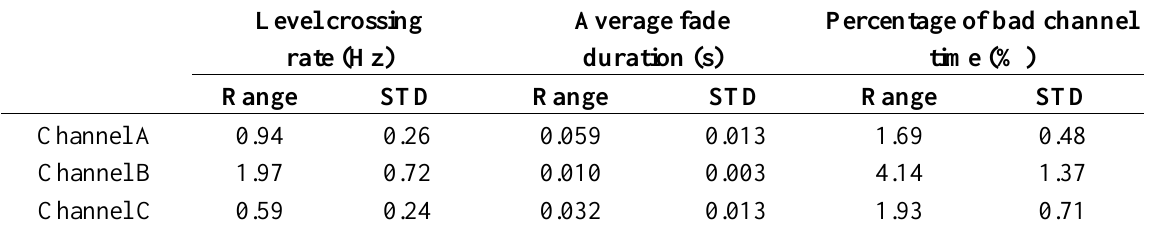
Table 2. Results of the statistical dispersion of level crossing rate, average fade duration and percentage of bad channel time for channel A, channel B and channel C. Level crossing Average fade Percentage of bad channel rate (Hz) duration (s) time (%) Range STD Range STD Range STD Channel A 0.94 0.26 0.059 0.013 1.69 0.48 Channel B 1.97 0.72 0.010 0.003 4.14 1.37 Channel C 0.59 0.24 0.032 0.013 1.93 0.71